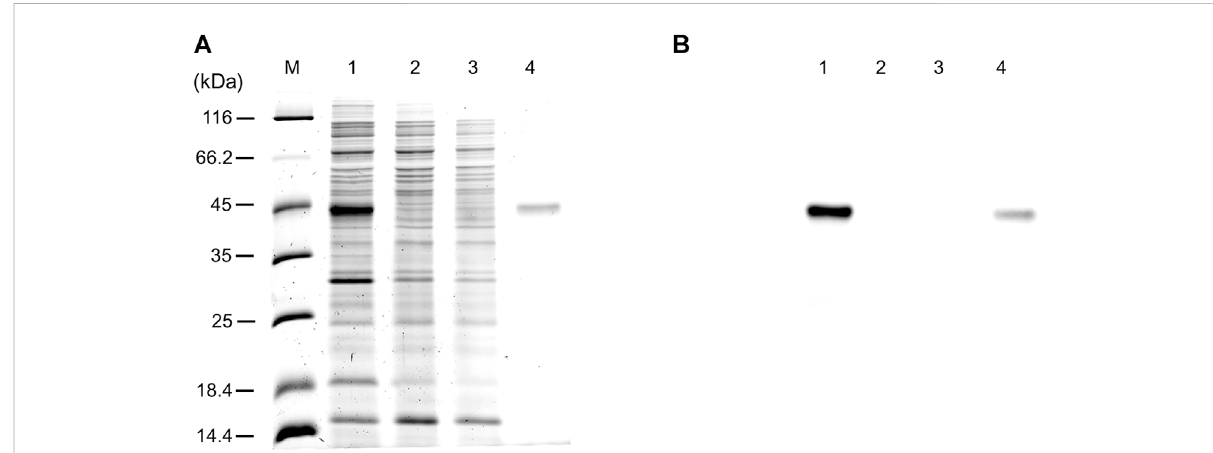
FIGURE 3 hxCT puri fi cation. (A) Proteins were separated by SDS – PAGE and visualized by a stain-free procedure as described in materials and methods: laneM, pageruler unstained marker;lane1: sampleas inFigure2lane8solubilized before IMACloading; lane2: fl owthrough fractioncontainingthe unbound proteins; lane 3: fraction of the protein eluted with washing buffer added with 10 mM imidazole; lane 4: fraction of the protein eluted with washing buffer added with 500 mM imidazole. (B) Western blotting using anti His antibody of the samples loaded as in (A)